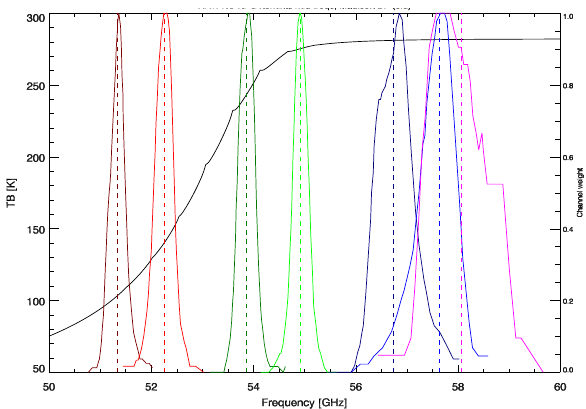
Fig. 1. Brightness temperature as a function of frequency in the microwave spectrum (V-Band: 50–60GHz). The spectrum (black line) is calculated for the long-term average Payerne atmospheric state. The colored, dashed vertical lines show the center frequencies of the MWR HATPRO channels together with their band passes (normalized to 1).